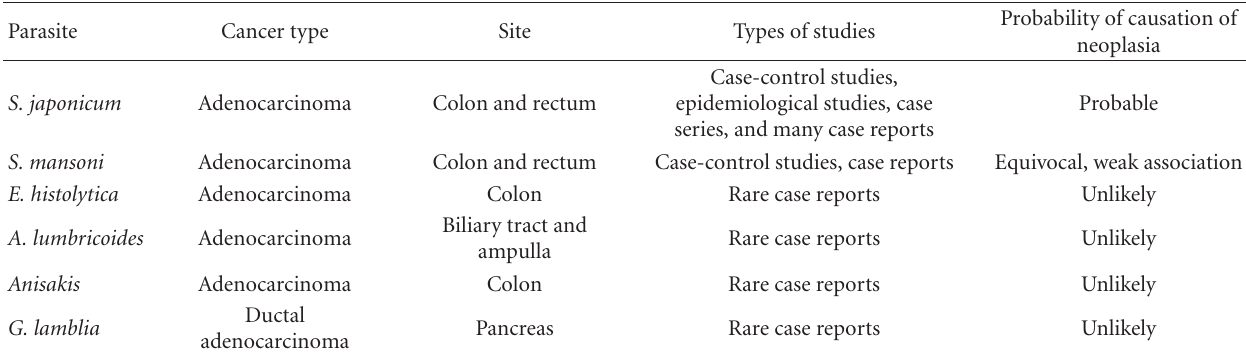
Table 1: Summary of evidence linking gastrointestinal parasites and